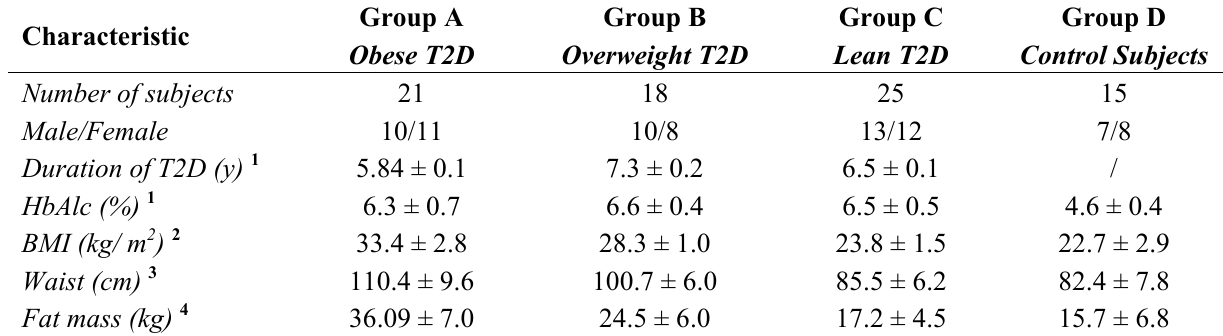
Table 1. Metabolic and anthropometric characteristics of the study